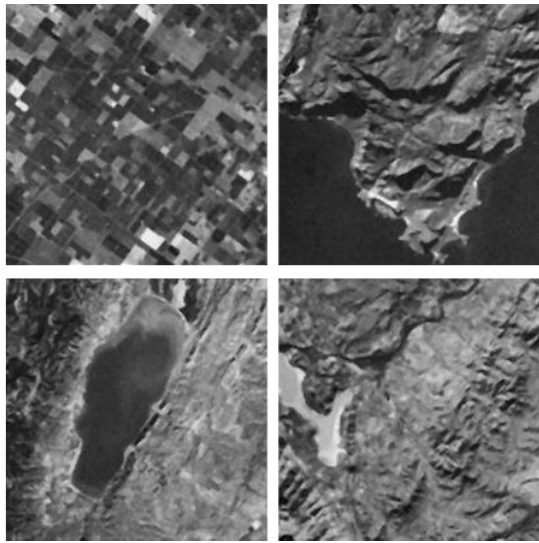
Fig. 16. Processed